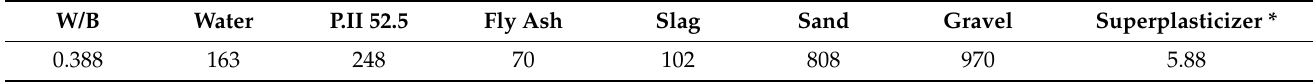
Table 1. Concrete composition in kg/m 3 .